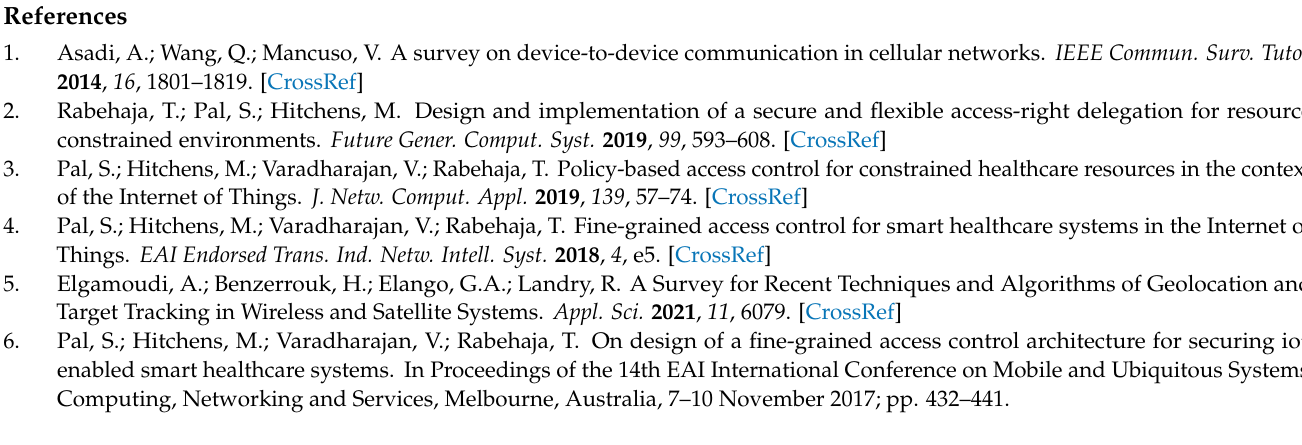
Figure 12. ISS two-line element data. This contains information e.g., the satellite catalog number, international designators, and the first and second derivatives of the mean motion, allowing for derivation of position, velocity, and